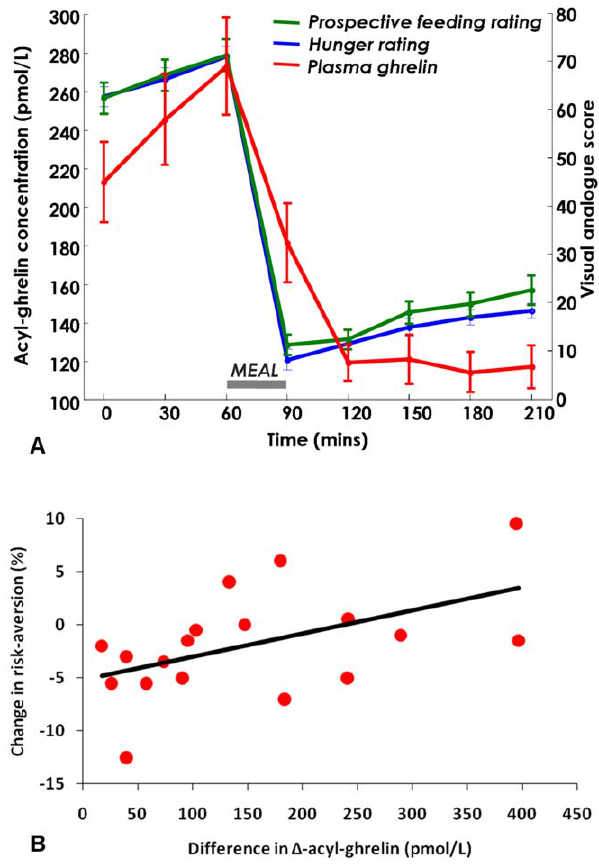
Figure 3. Metabolic state and change in risky choice. A. Change in hunger VAS (blue), prospective feeding VAS (green), and plasma acyl- ghrelin levels (red) over time-course of session, assayed every 30 mins, averaged across sessions and subjects. There was a significant drop in both hunger ratings and plasma acyl-ghrelin levels (p , 0.001) after eating; the timecourse of this fall was slower for acyl-ghrelin, showing that this peripheral signal of acute nutrient intake is delayed. Error bars show s.e.m. B. Change in percentage of risky choices significantly correlated with the difference in D -ghrelin measurements (within week change in ghrelin from baseline), measured one hour after the meal. p=0.022, r 2 =0.22 (N=18).